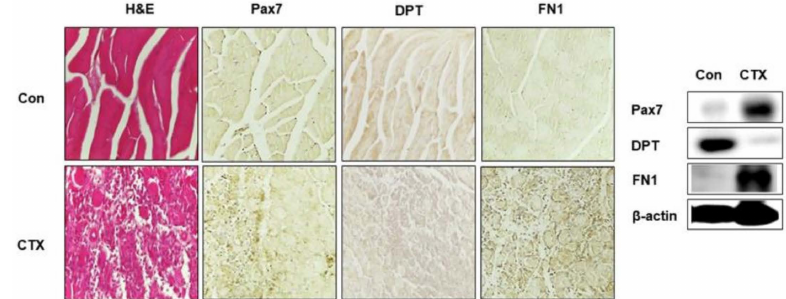
Figure 6. Muscle regeneration analysis. Cardiotoxin (CTX) was injected in the gastrocnemius muscle of mice and maintained for 3 days. The muscle tissue was collected, and morphology was observed by H & E staining. Expressions of Pax7 (control), DPT, and FN proteins by immunohistochemistry and Western blot are